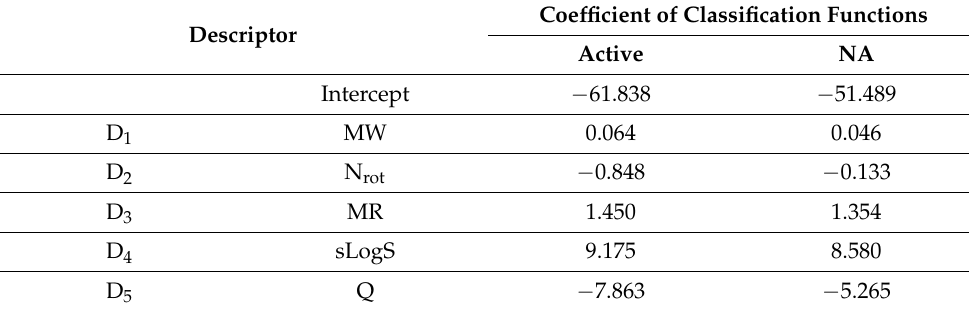
Table 4. Physicochemical descriptors from the best subset and the corresponding coefficients of classification functions.